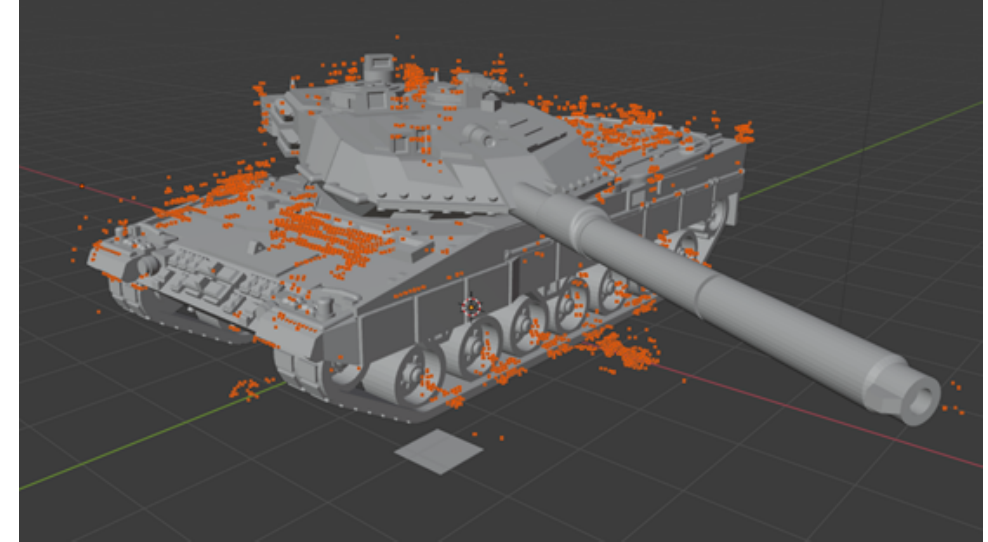
Figure 14. Point cloud from Figure 13 together with original Leopard tank CAD